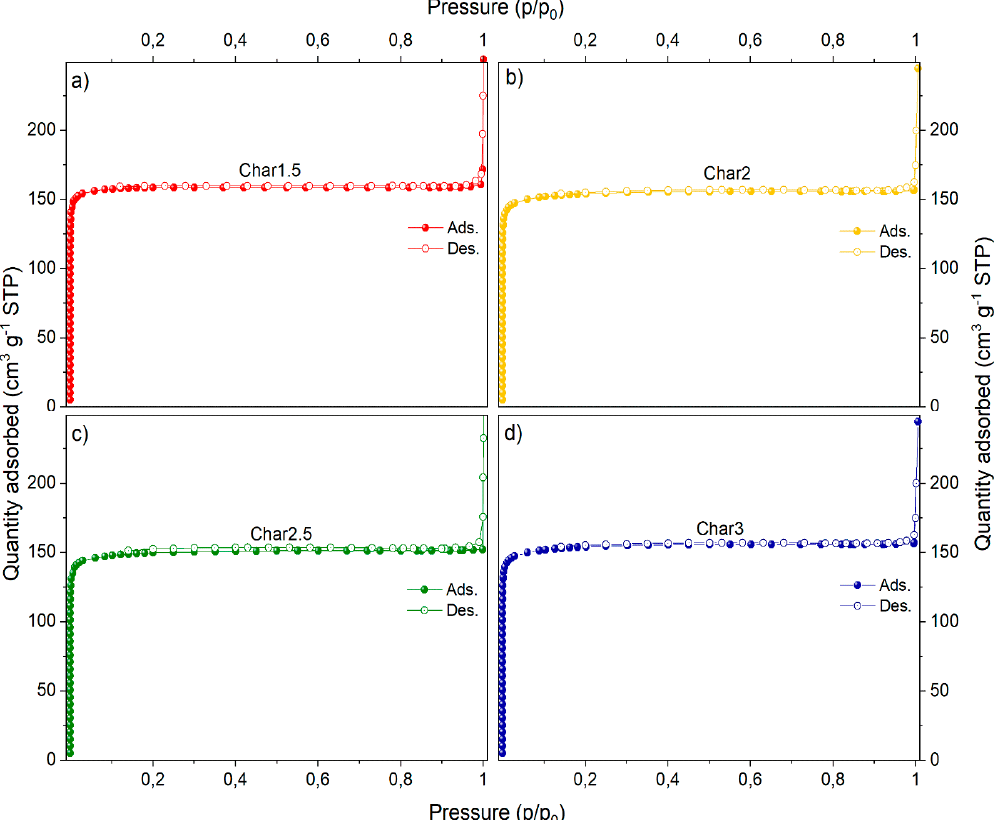
Figure 3. N 2 adsorption/desorption isotherms at 77 K of Char1.5, Char2, Char2.5 and Char3.